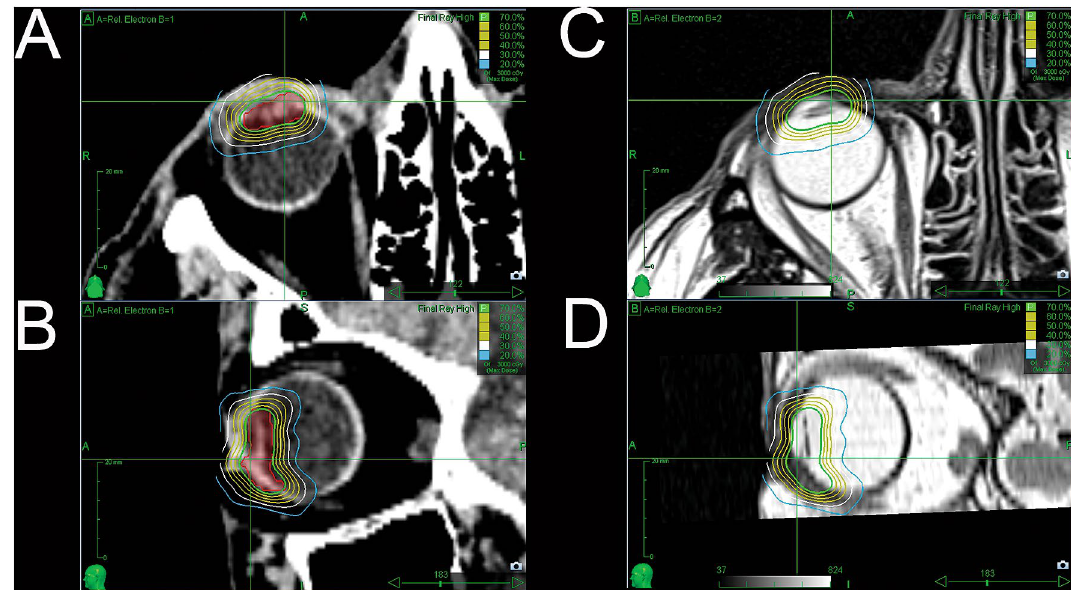
Figure 4. Two treatment plans are depicted in this figure. We used a donut shaped pattern in all our cases in order to make sure that the entire tumor was within the radiation field. ( A , B ) as well as ( C , D ) show the planning target volume with isodose lines from two different perspectives.